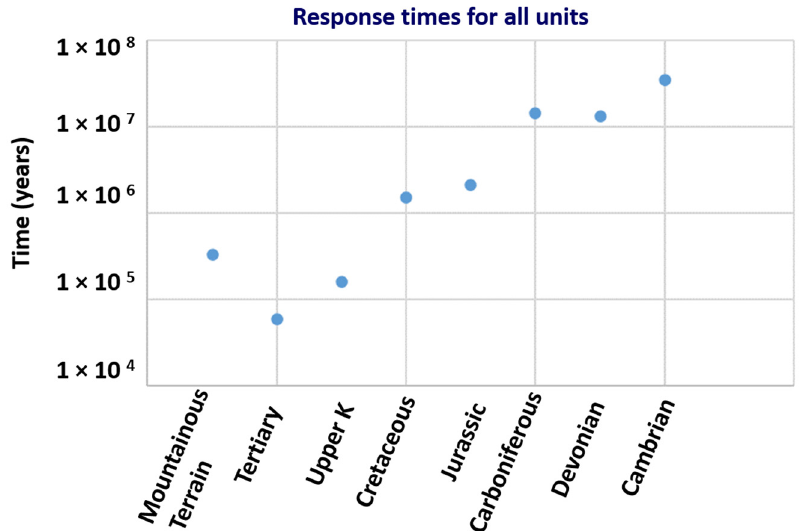
Figure 21. Response times for all units.